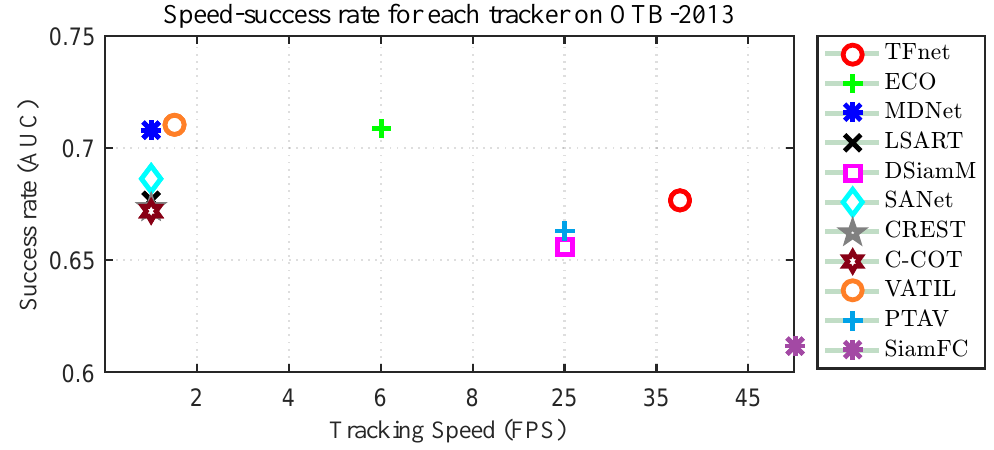
Figure 3. Speed-accuracy plot of state-of-the-art trackers on the OTB2013 dataset.